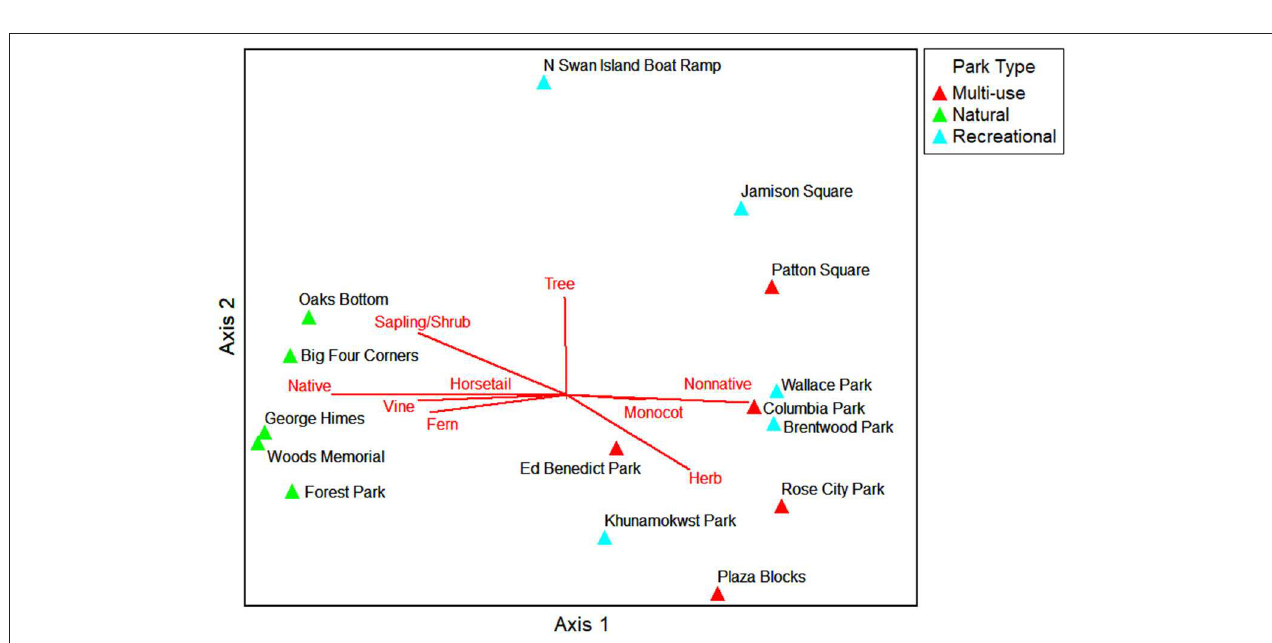
FIGURE 8 | NMS ordination Axes 1 and 2 for the parks in species space. Trait variables that are strongly related to the individual ordination axes ( r 2 > 0.2) are shown as joint plots (radiated red lines).